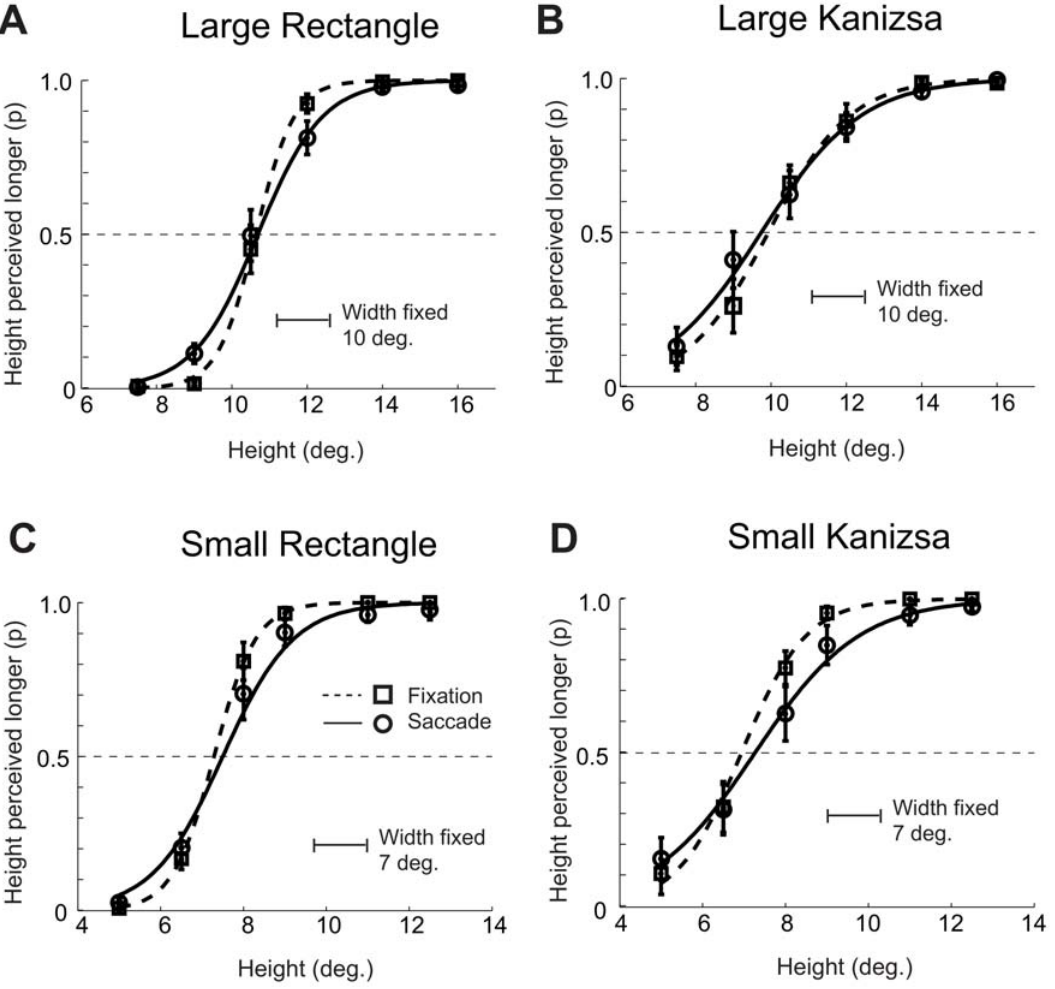
Figure 8. Experiment 2: Proportion of participants reporting the height was longer than the fixed width. Vertical bars indicate SEMs.